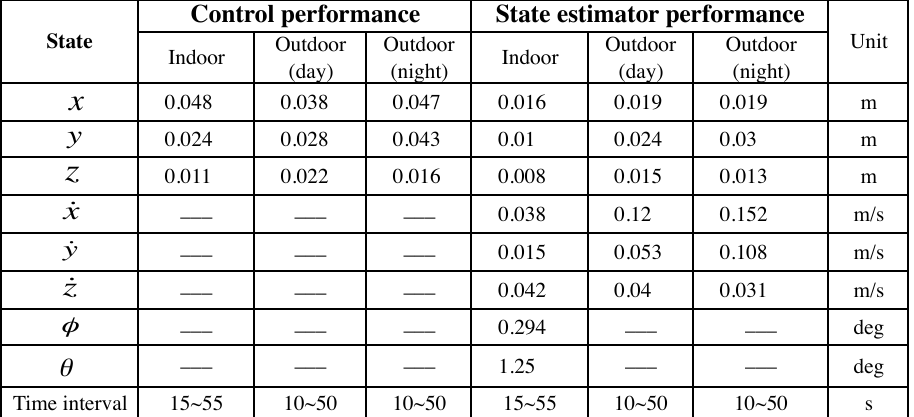
Figure 22. PBVS hovering (standard deviation).